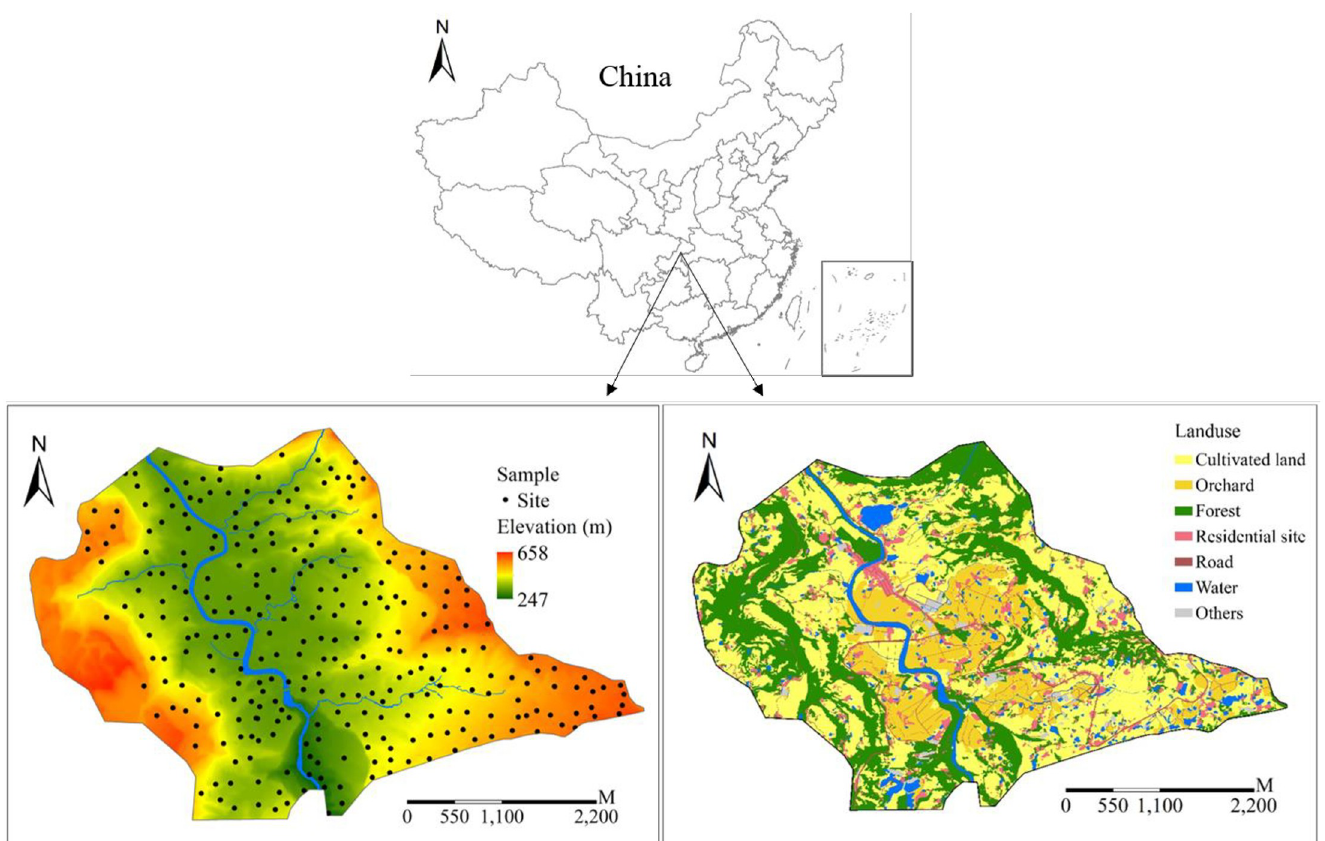
Fig 1. Maps of study area locations, soil sample sites, digital elevation model, and land use